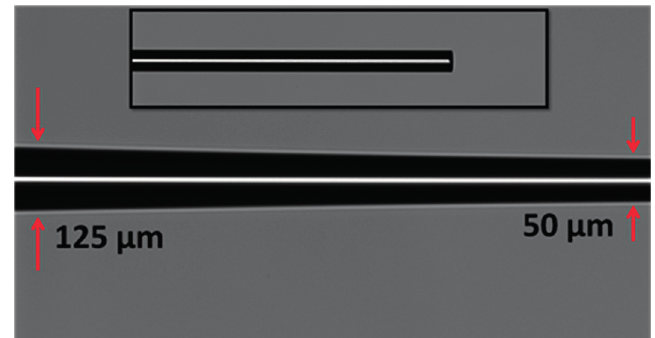
Figure 3. The image of the fabricated tapered optical fiber. The inset shows the tip of the tapered optical fiber.